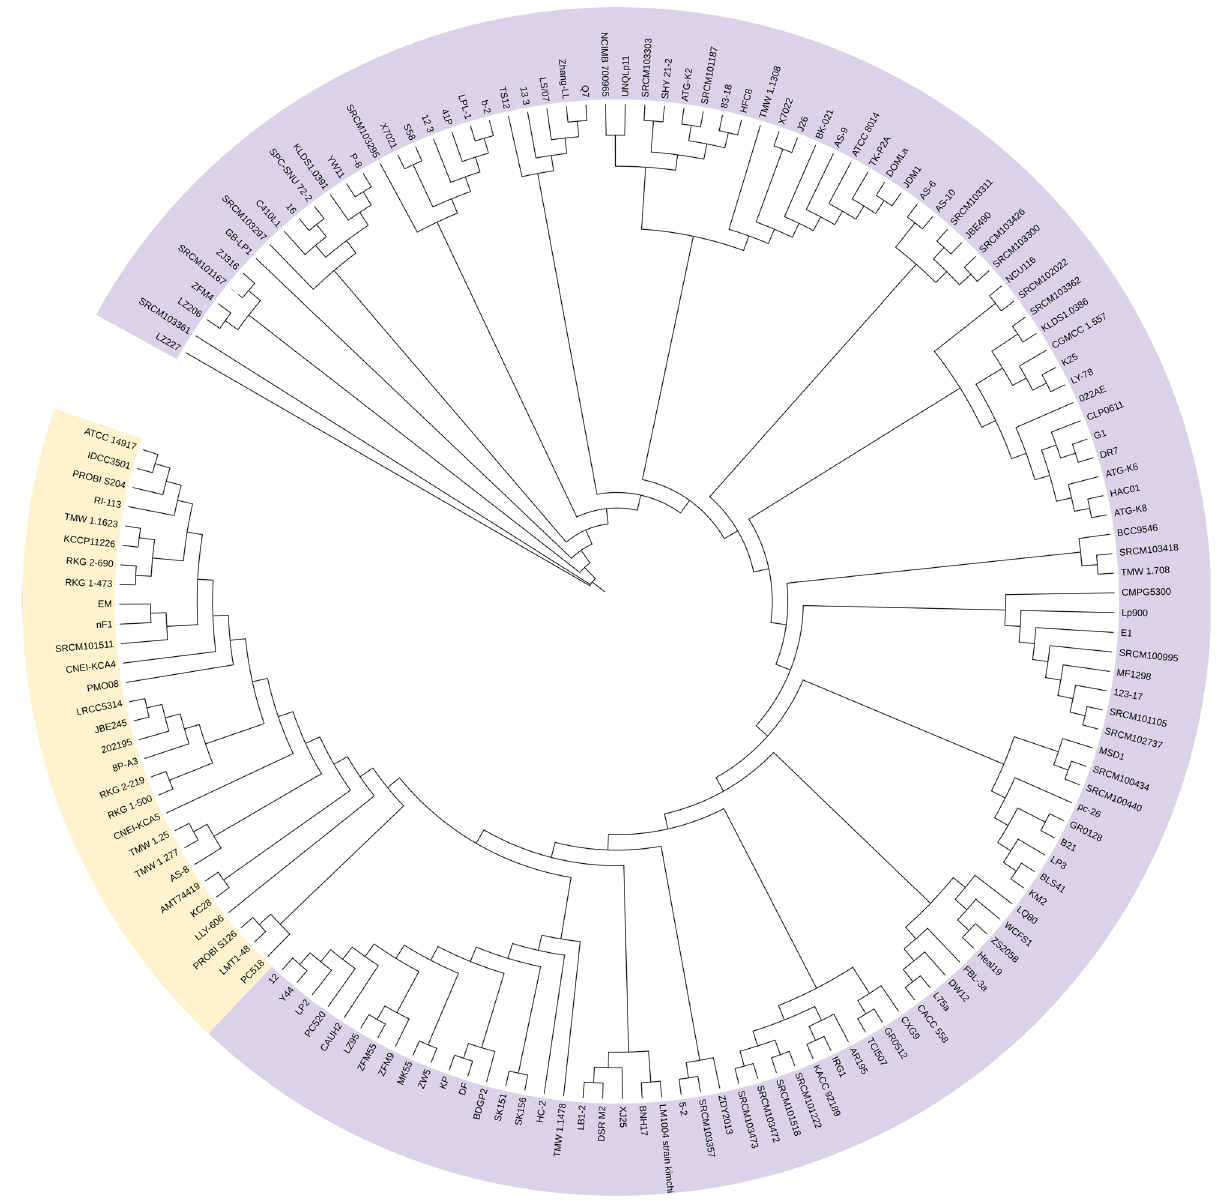
Figure 6. Phylogenetic tree of 155 L. plantarum strains. Genome sequences were obtained from BV-the BRC (149) and were analyzed with the ones obtained from the TanA+ strains selected in this study (6). In yellow, a cluster comprising 29 strains, two lacking the tanA gene (LLY-606 and PC518). The core genome-based phylogeny was performed by the randomized axelerated maximum likelihood in the BV-BRC. This image is available interactively at https:// itol. embl. de/ tree/ 14211 71881 06405 05164 64442